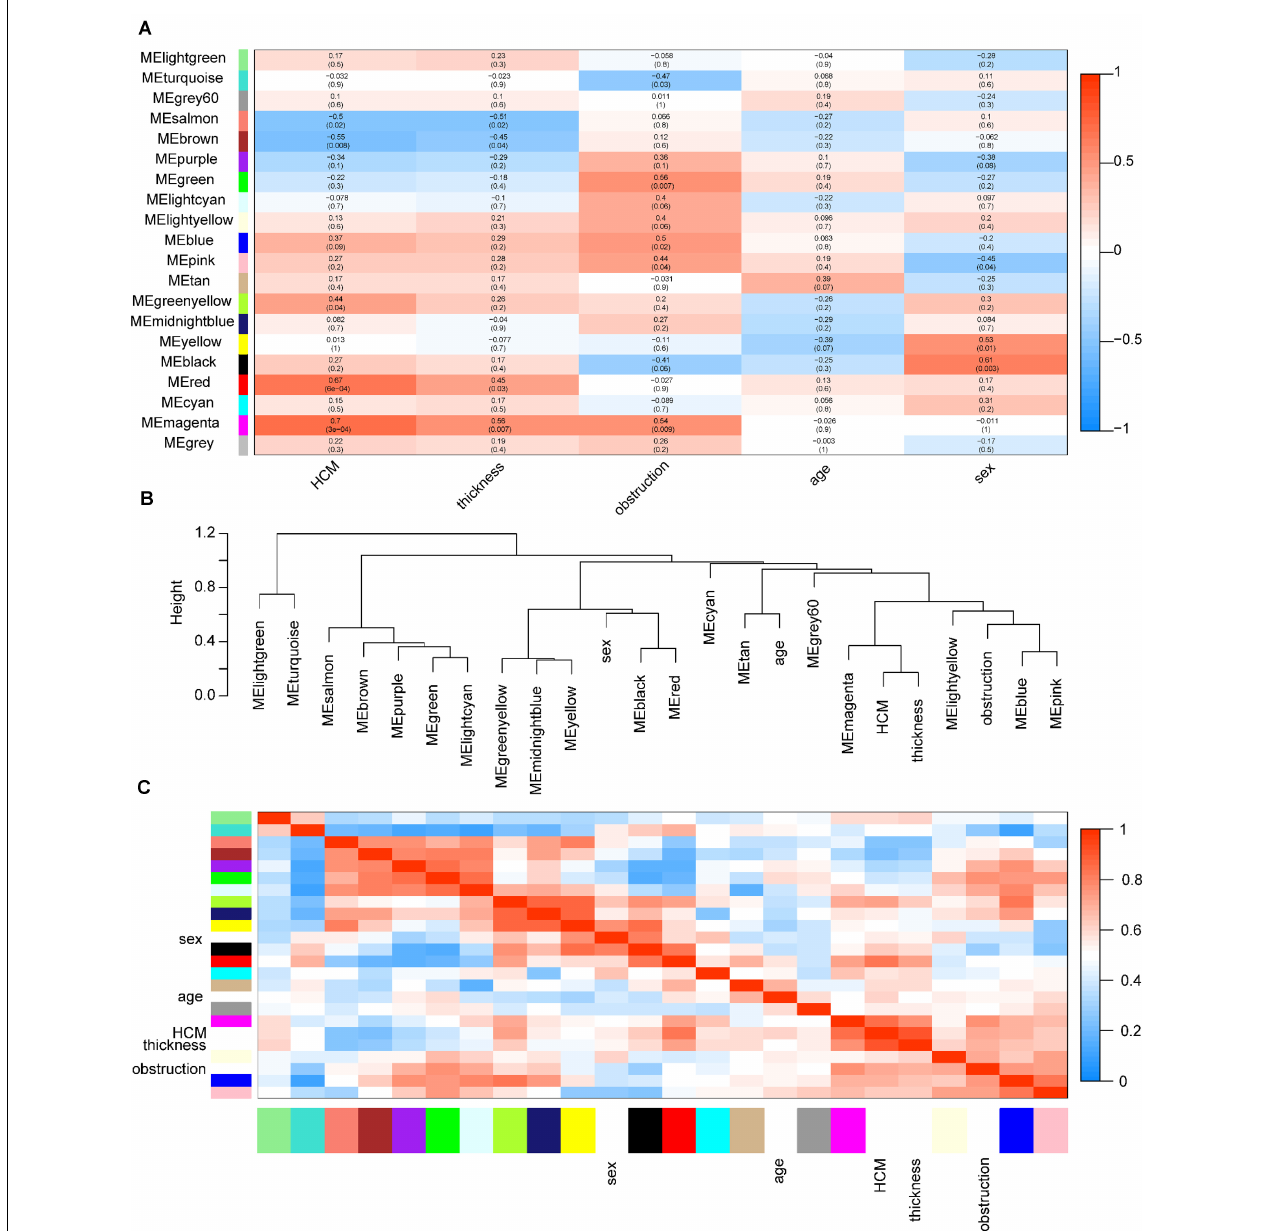
FIGURE 3 | Identification of key modules in HCM. (A) Module-trait associations. Each row corresponds to a module eigengene, column to a trait. Each cell contains the corresponding correlation coefficient and p -value. The table is color coded by correlation according to the color legend. Red color indicated a positive correlation, and blue color indicated a negative correlation. The names of modules were showed in the left of the panel. The magenta and red modules showed the most significant association with HCM. (B) The eigengene dendrogram of correlated eigengenes. The dendrogram indicates that the magenta module is highly related to HCM and maximum left ventricular wall thickness. (C) Heatmap of modules associations. The heatmap in the panel shows the eigengene adjacency. Red color indicated a remarkable correlation between modules. The color blocks in the left and bottom of the panel corresponded to modules. HCM, hypertrophic cardiomyopathy; ME, module